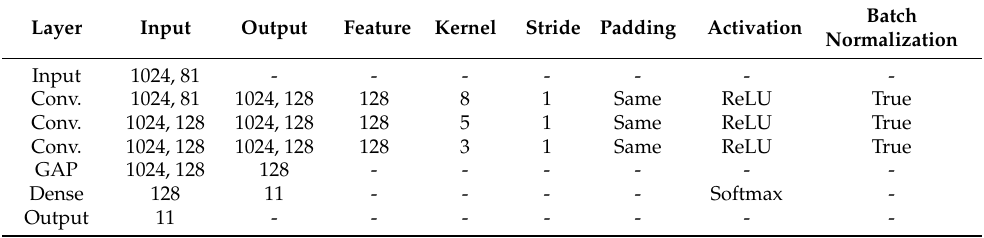
Table 2. Detail of architecture